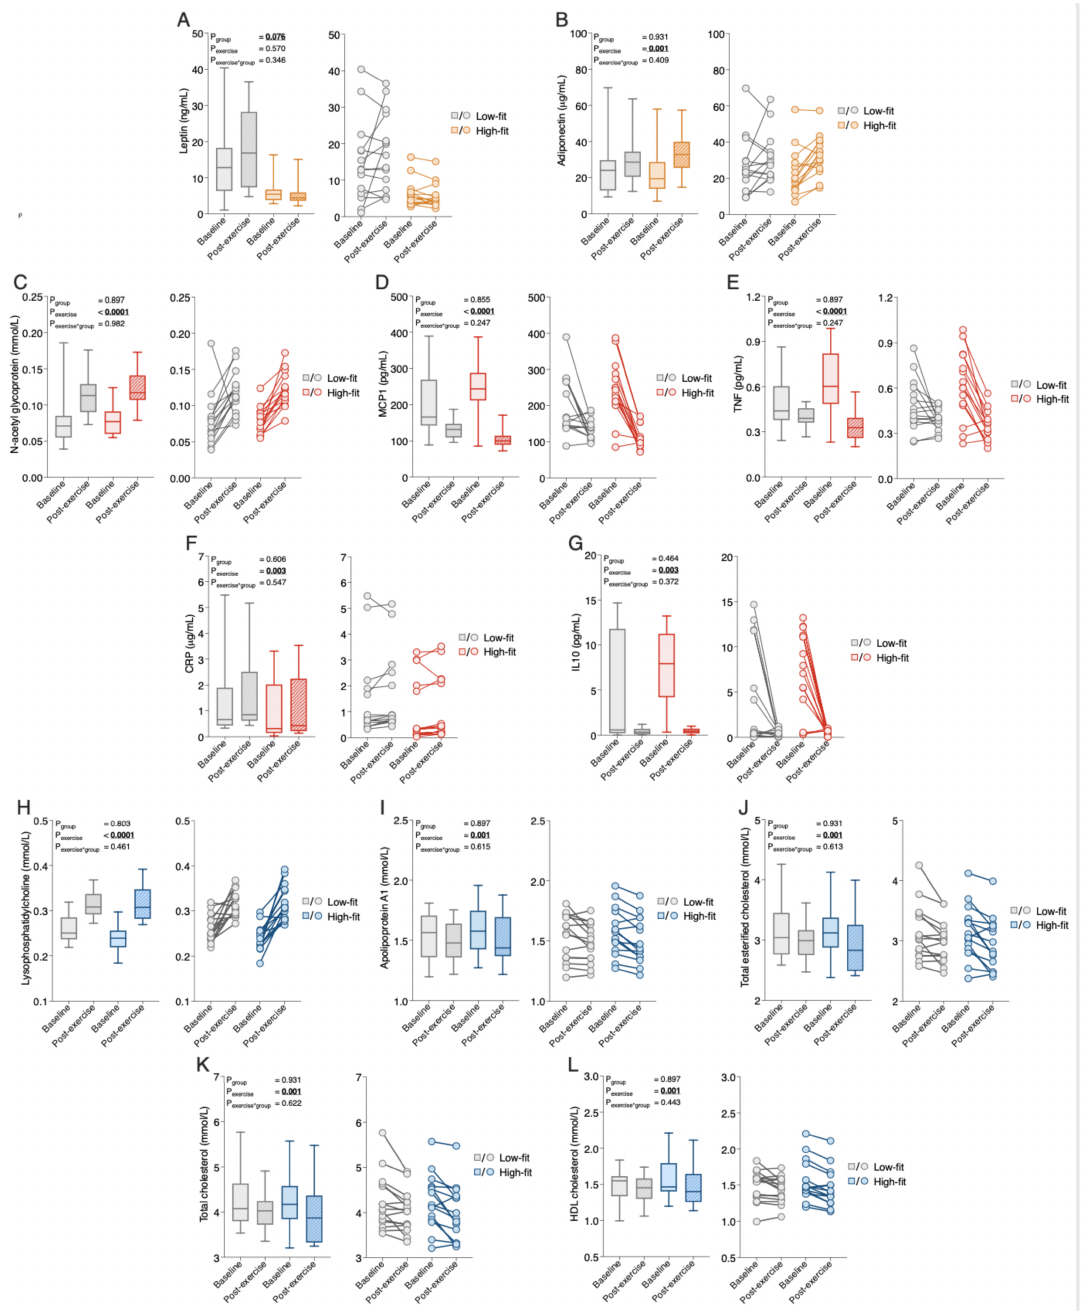
Figure 2. The response of the top five significantly regulated biomarkers and metabolic parameters within each biomarker and metabolic parameter category by fitness level, or a recent bout of